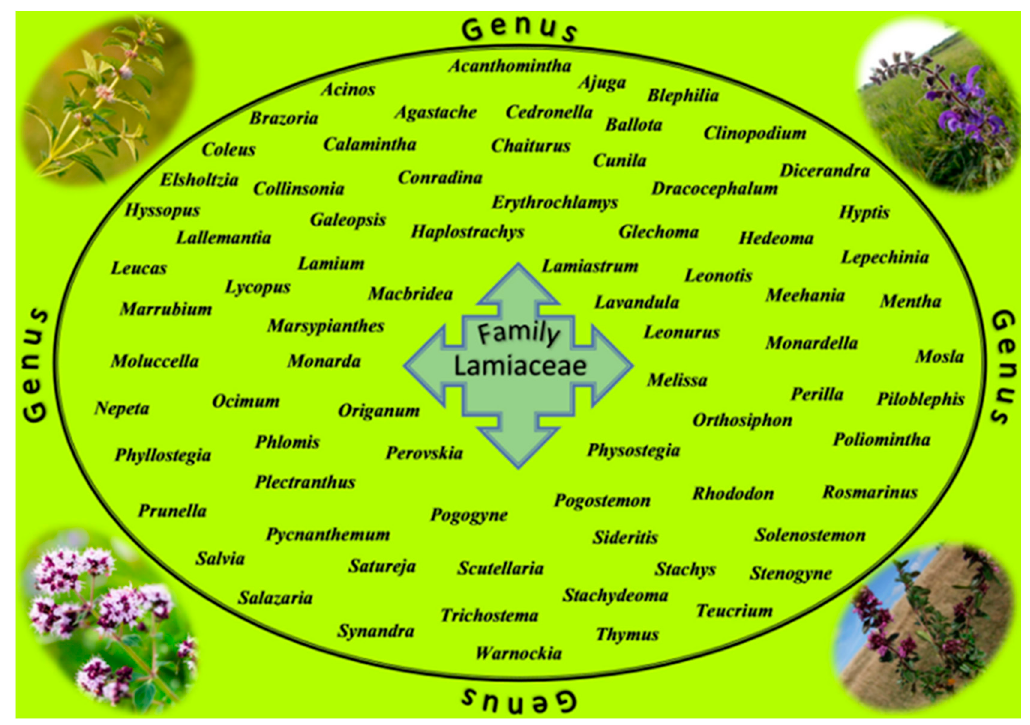
Figure 1. Selected genera belonging to the Lamiaceae family.